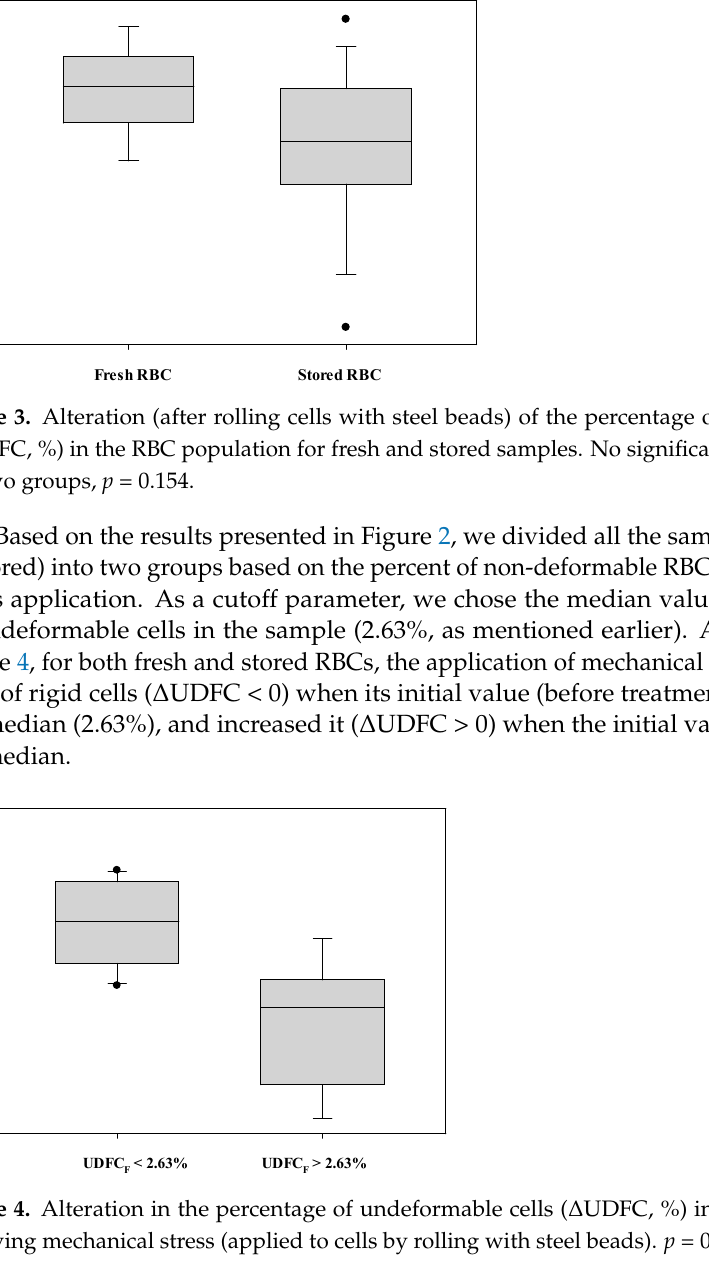
6 of 15 Figure 2 . Percentage of undeformable cells (%UDFC) in samples collected before (RBC B ) and after mechanical stress application (RBC MS ). Mechanical stress was applied to cells by rolling freshly do- nated and stored RBCs with steel beads. Identical symbols designate the same RBC sample before and after applying mechanical stress. No significant difference between the two groups was ob- served, p = 0.45. In addition, we analyzed the impact of mechanical stress separately for freshly do- nated and stored RBCs. Figure 3 shows that the change in the proportion of rigid cells is primarily positive ( ∆ UDFC > 0) for freshly-donated cells and negative for stored RBC. Thus, mechanical stress leads predominantly to an increase in the fraction of non-deform- able cells in the case of freshly donated RBCs, and, conversely, to a decrease in the fraction of rigid cells when stored RBCs are analyzed. The observed difference in the response to